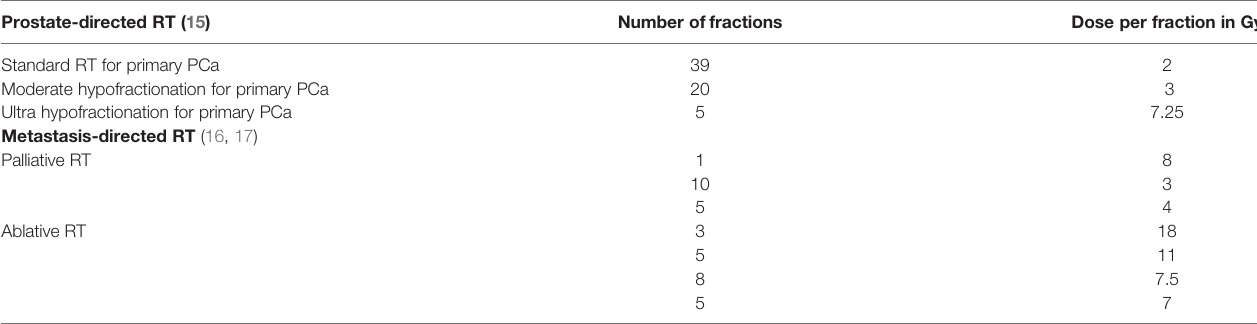
RT, radiation therapy; Gy, Gray; PCa, Prostate